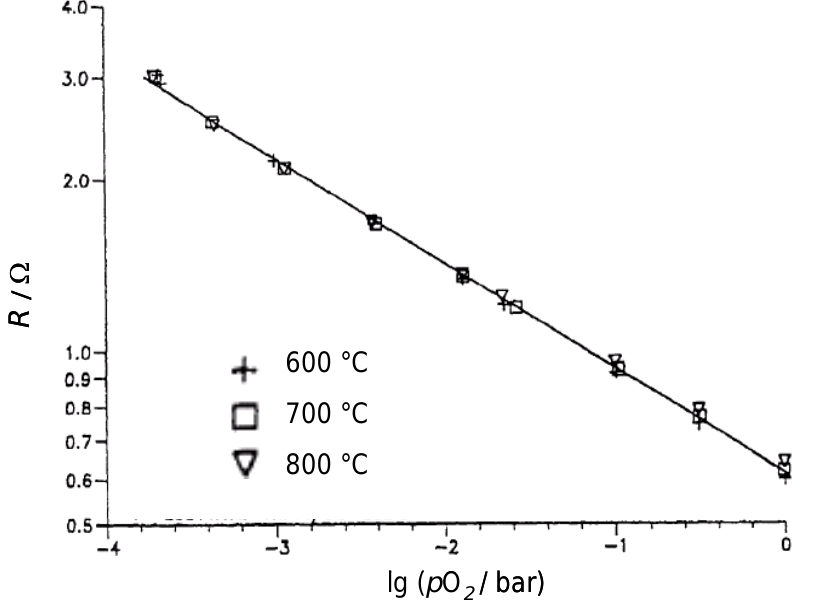
)-characteristic of a La 2